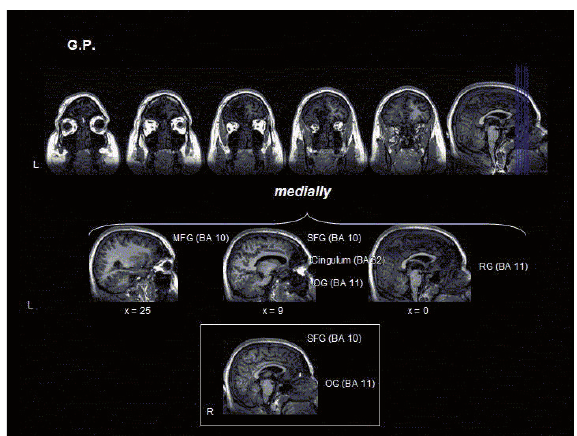
Figure1:LocalizationofbraindamageinG.P.Seethetextfordetails.